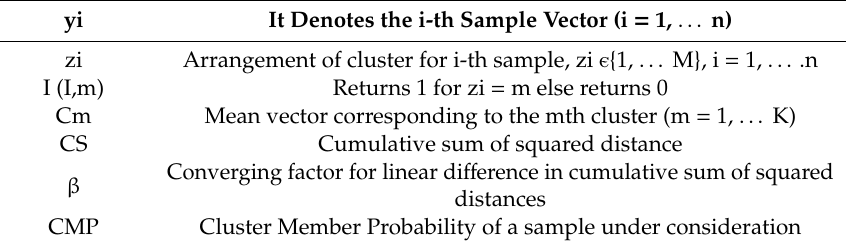
Table 12. Parameters used in Integrated Supervised K-Means. yi